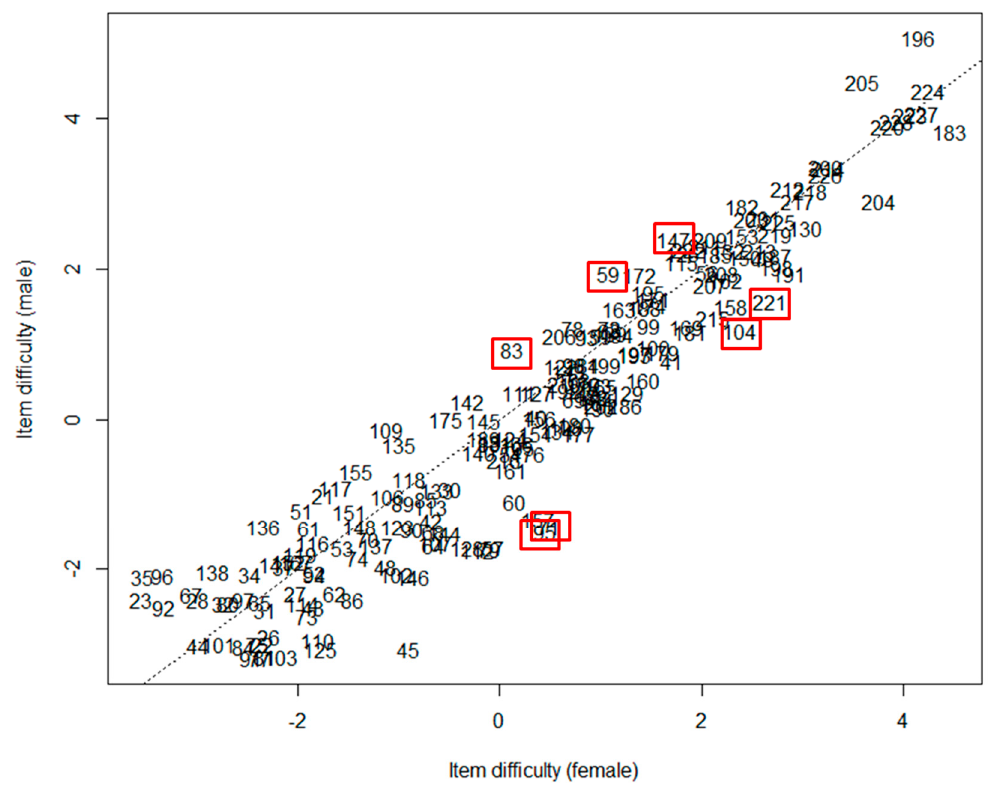
ffi culty (items with di ff erential item functioning (DIF) in Figure 3. Gender-based item difficulty (items with differential item functioning (DIF) in boxes). Figure 3. Gender-based item di